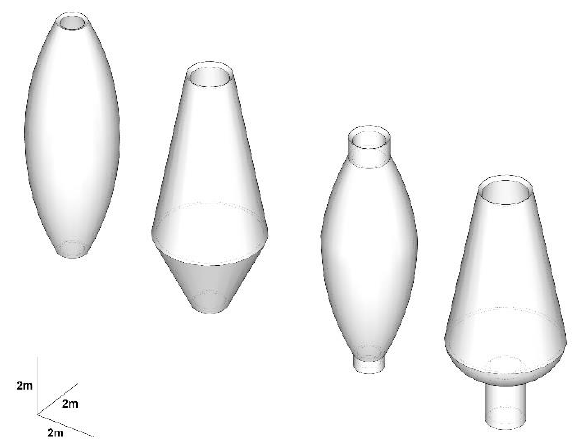
Figure 2: Three dimensional analyses of blast furnace interior surface (non-dimensional thickness) of the main typology in use during XIX century. These shapes were utilized before the great improvement by new technologies applied to the field of iron production at large scale (elaboration by the authors based on historic drawings available in System Der Metallurgie: Geschichtlich, Statistisch, Theoretisch Und Technisch, Fuenfter Band by Carl Johann Bernhard